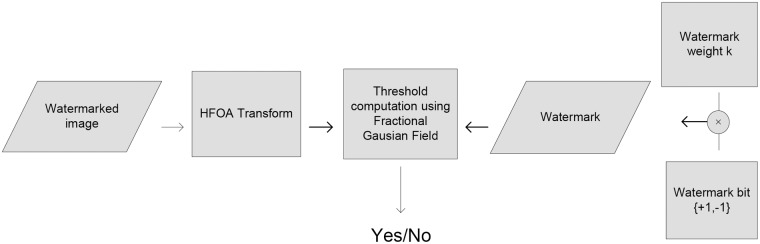
Watermark Detection.